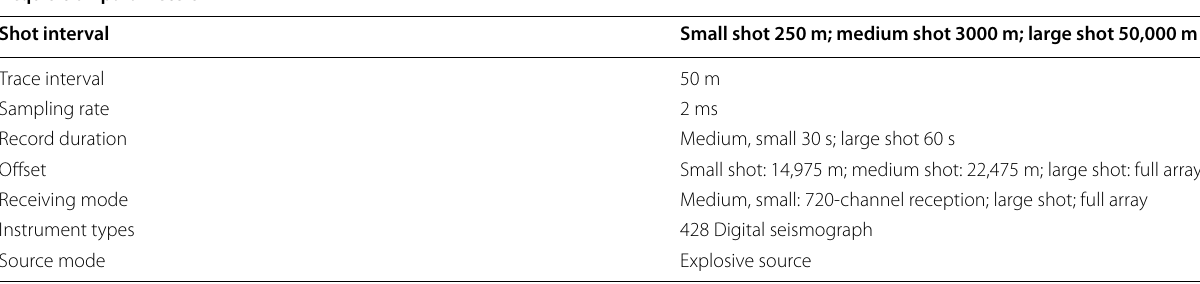
Table 1 Deep reflection seismic data acquisition parameters Acquisition